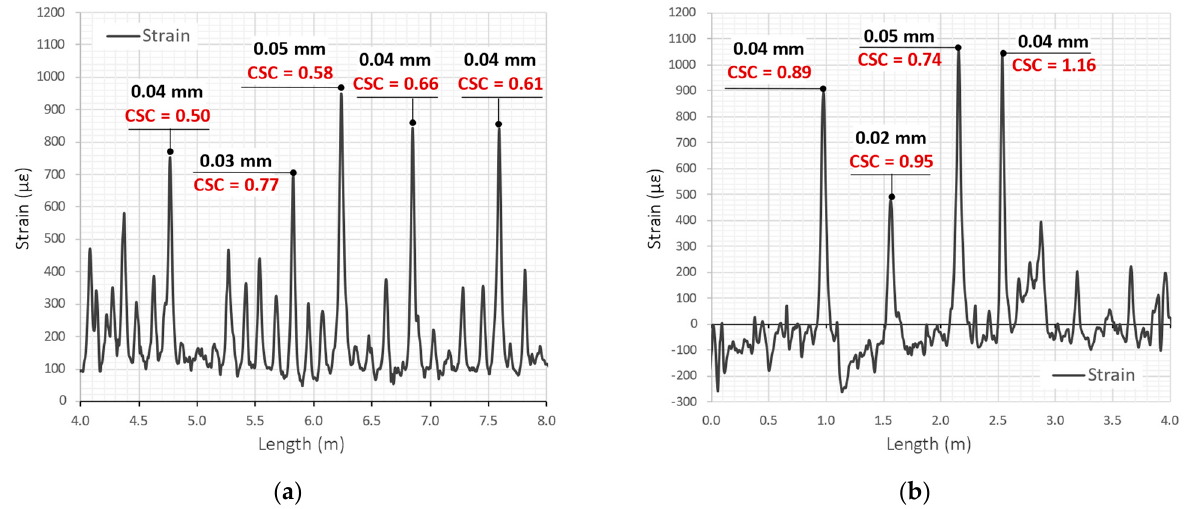
Figure 31. Example analysis of crack widths and crack shape coefficients based on measured strain profiles in the bridges in question: ( a ) near the city of Sande; ( b ) near the Frankfurt am Main.